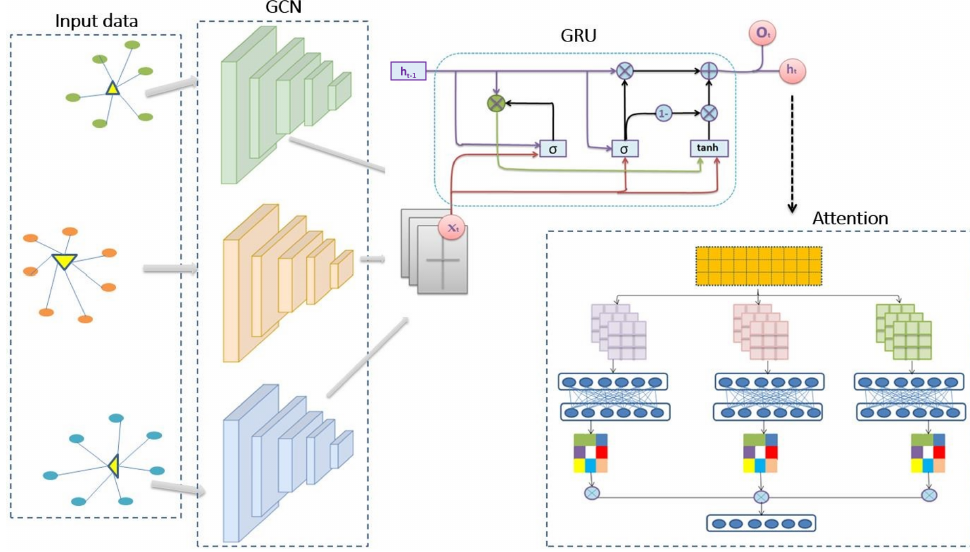
Figure 2. Proposed MHSA–GCN architectural overview of GCN, GTU, and